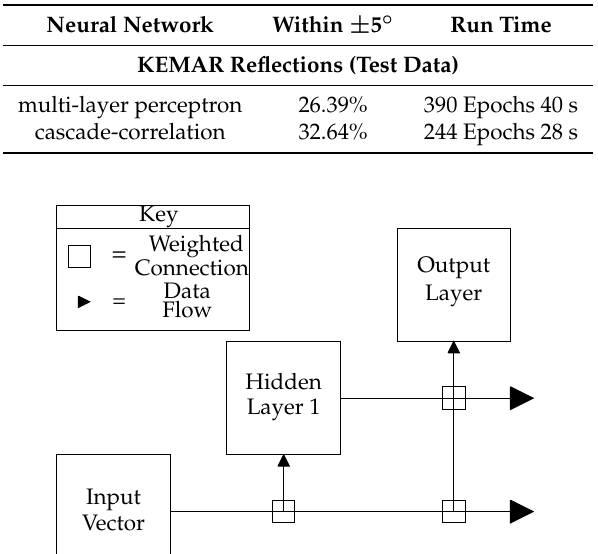
Table 2. Comparison of prediction accuracy for the reflected component measured with the KEMAR 45BC using additional measurements at receiver rotations of ± 90 ◦ using a multi-layer perceptron and cascade-correlation neural network. Both the multi-layer perceptron and the cascade-correlation neural network had one hidden layer with 128 neurons and an output layer with 360 neurons and were trained using the procedure discussed in Section 2.3.